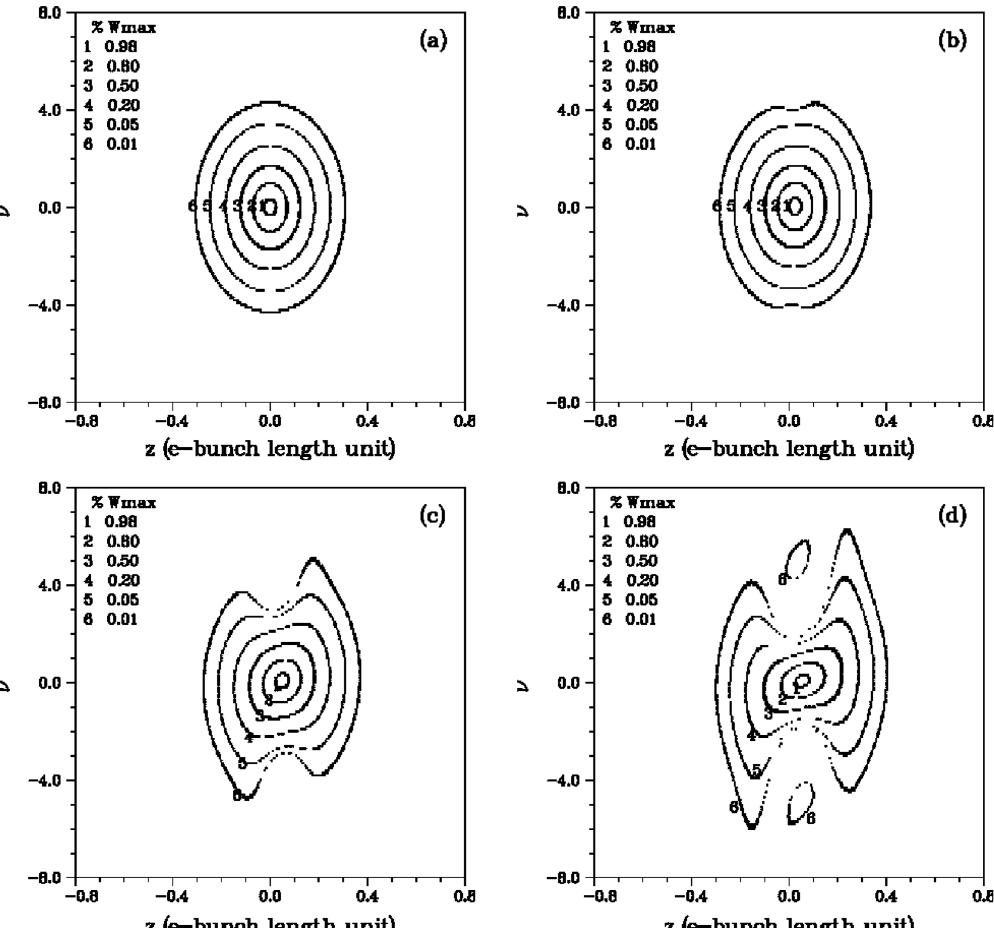
FIG. 7. Phase space distribution of the main harmonic at different positions inside the undulator: (a) Z ¼ 0 m , W max ¼ 5 : 57 (cid:2) 10 (cid:1) 3 ; (b) Z ¼ 3 : 64 m , W max ¼ 5 : 25 (cid:2) 10 (cid:1) 1 ; (c) Z ¼ 6 : 58 m , W max ¼ 6 : 79 (cid:2) 10 1 ; (d) Z ¼ 7 : 56m , W max ¼ 1 : 37 (cid:2) 10 2 ; same parameters as in Fig.